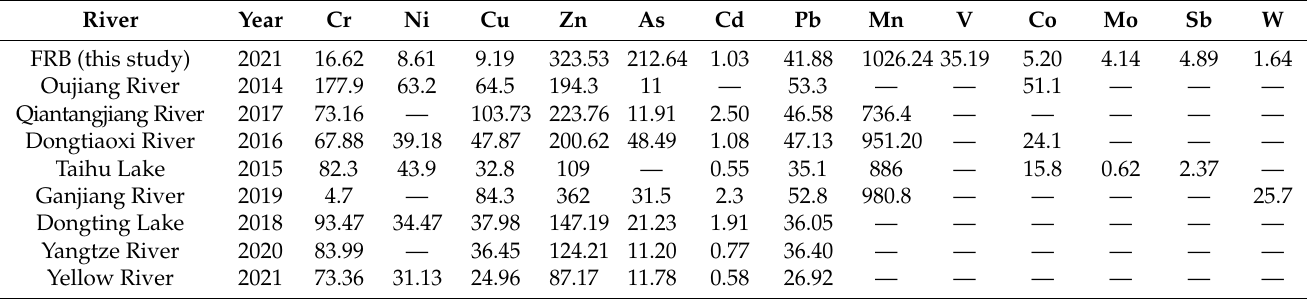
Table 5. The concentration of heavy metals in sediments of different rivers in China